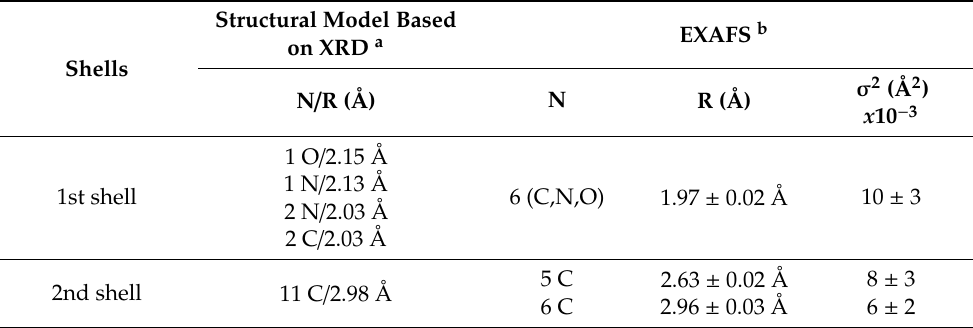
Table 1. Average coordination number obtained by EXAFS curve